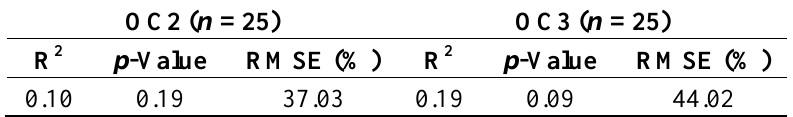
Table 6. Statistics for OC2 and OC3 applied by SeaDAS for the Itumbiara Reservoir.